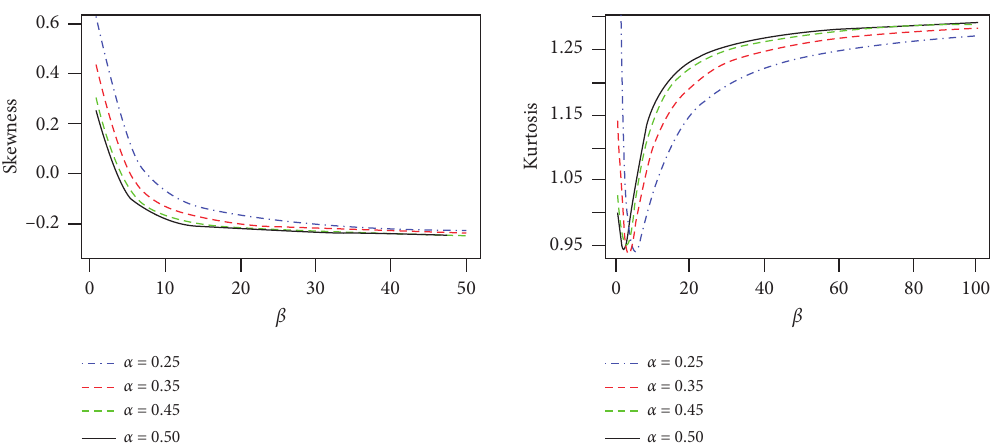
Figure 3: Skewness (left panel) and Kurtosis (right panel) curves for EPF distribution is